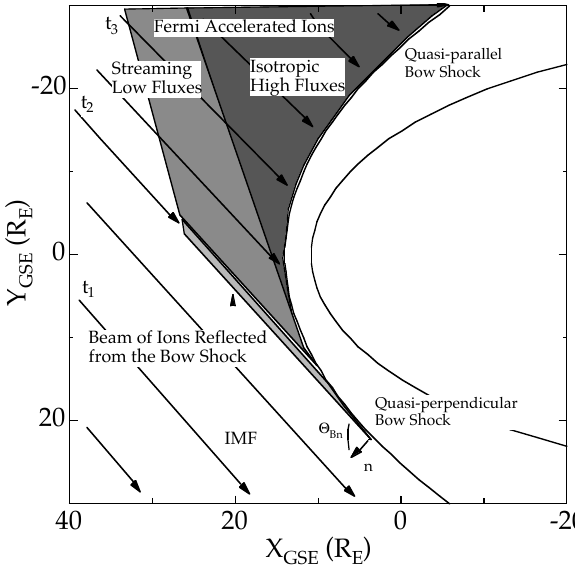
Fig. 1. Spatial distribution of suprathermal ion distributions in the foreshock. No suprathermal ions occur on magnetic field lines un- connected to the bow shock (t 1 ) . A beam of reflected or leaking ions can be found on magnetic field lines connected to the quasi- perpendicular bow shock (t 2 ) . A high flux of nearly isotropic ions can be found immediately upstream from the quasi-parallel bow shock. A lower flux of streaming ions can be found further up- stream (t 3 ).